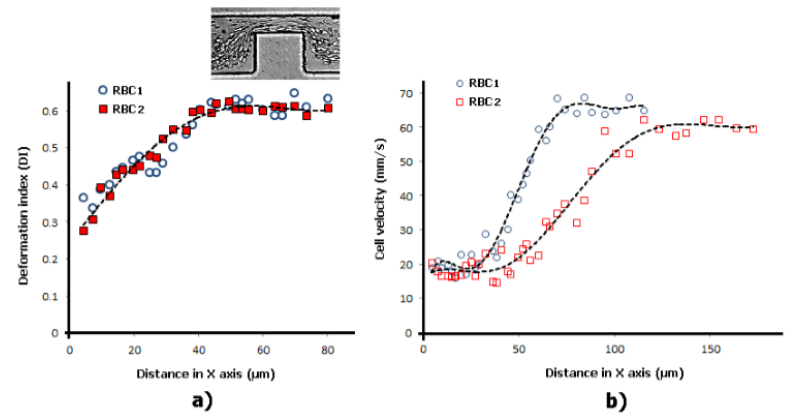
Figure 7. Individual RBCs ( a ) DI and ( b ) velocity flowing through a sudden contraction microchannel for the same flow rate. The X axis correspond to the main flow